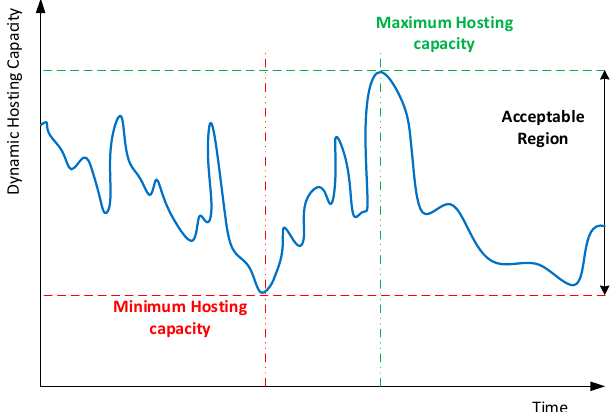
Figure 2. Dynamic hosting capacity (DHC(t)) approach.